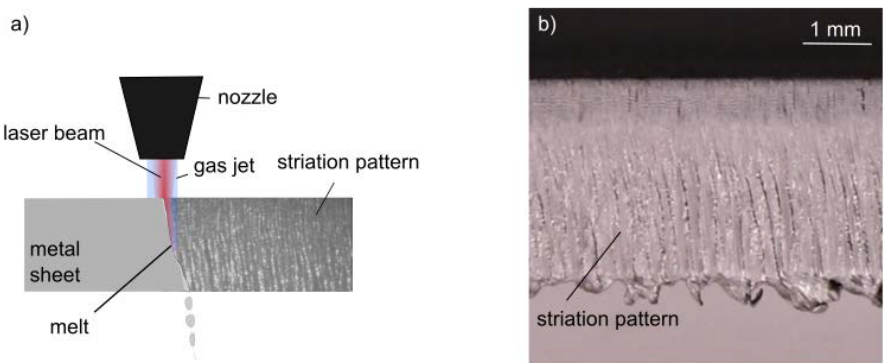
Figure 1. ( a ) Basic principle of laser beam fusion cutting of metals: the material is molten by the laser beam and accelerated by the gas jet. ( b ) Resulting cutting kerf with characteristic striation pattern.